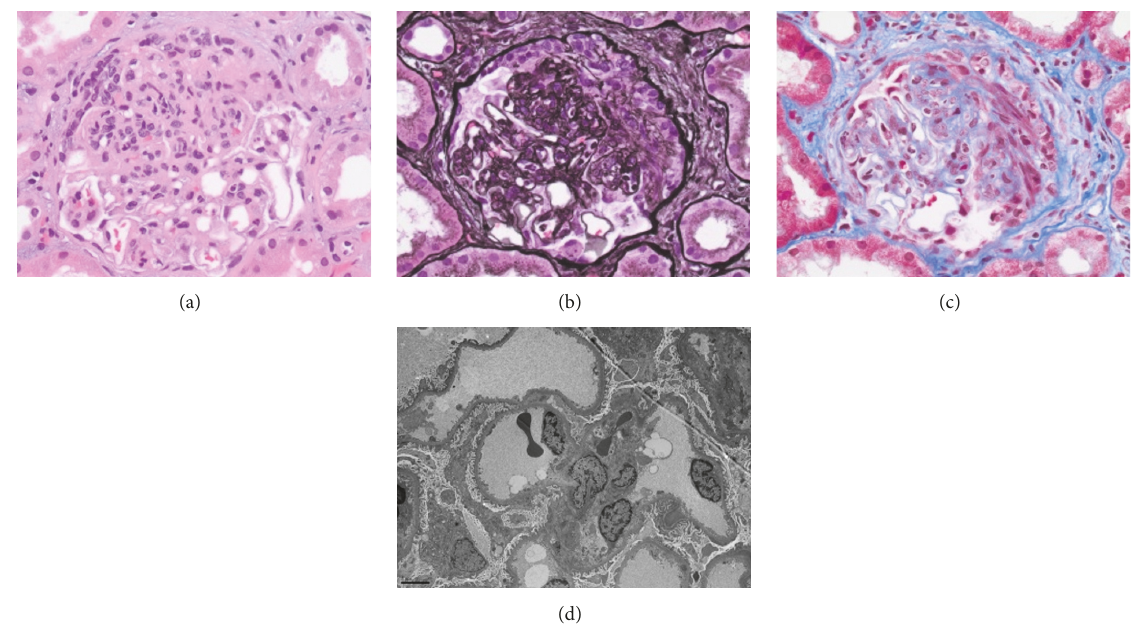
Figure 2: (a) Light microscopy. Hematoxylin and Eosin stain with decreased endocapillary proliferation of neutrophils with some karyorrhectic debris and moderate crescents. (b) Jones stain with an early fibroepithelial crescent. (c) Trichrome stain with crescent and focal mild interstitial fibrosis and tubular atrophy. (d) Electron microscopy. Minimal residual subendothelial electron dense deposits but no evidence of large subepithelial electron dense deposits “humps”.